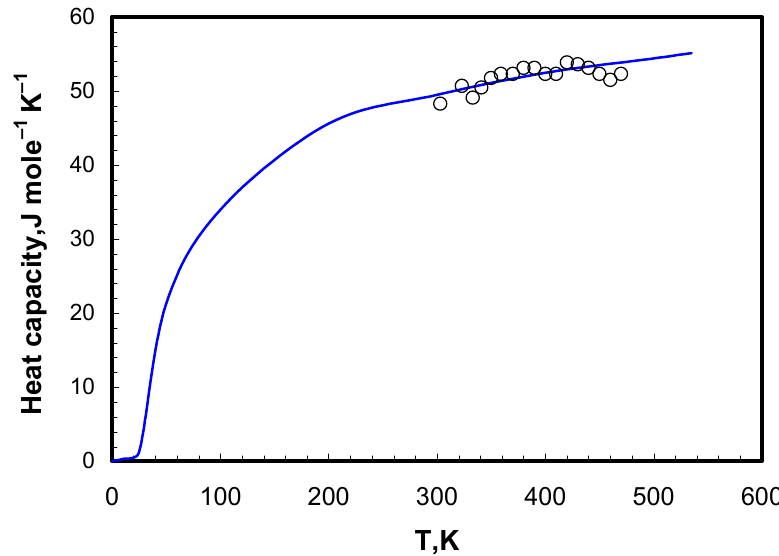
Figure 1. Heat capacity of LiCl-KCl-CsCl solid eutectic. ○ —our data, line—values calculated according to the additive law based on the data available from the literature [8,19].